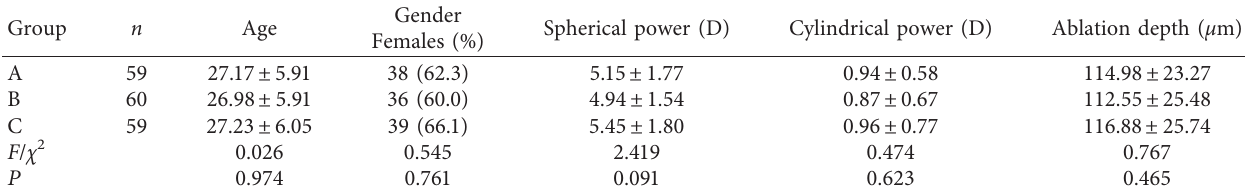
Table 1: Participants’ baseline